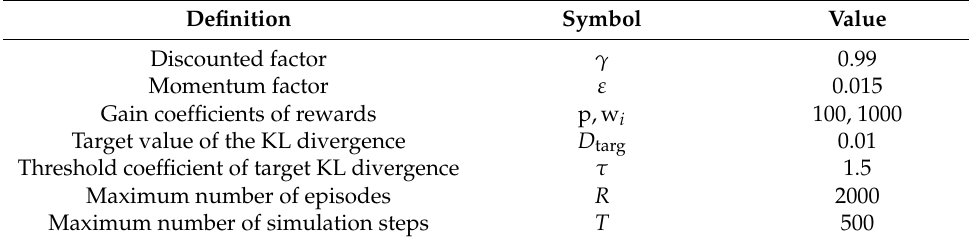
Table 1. Definitions and values of partial crucial